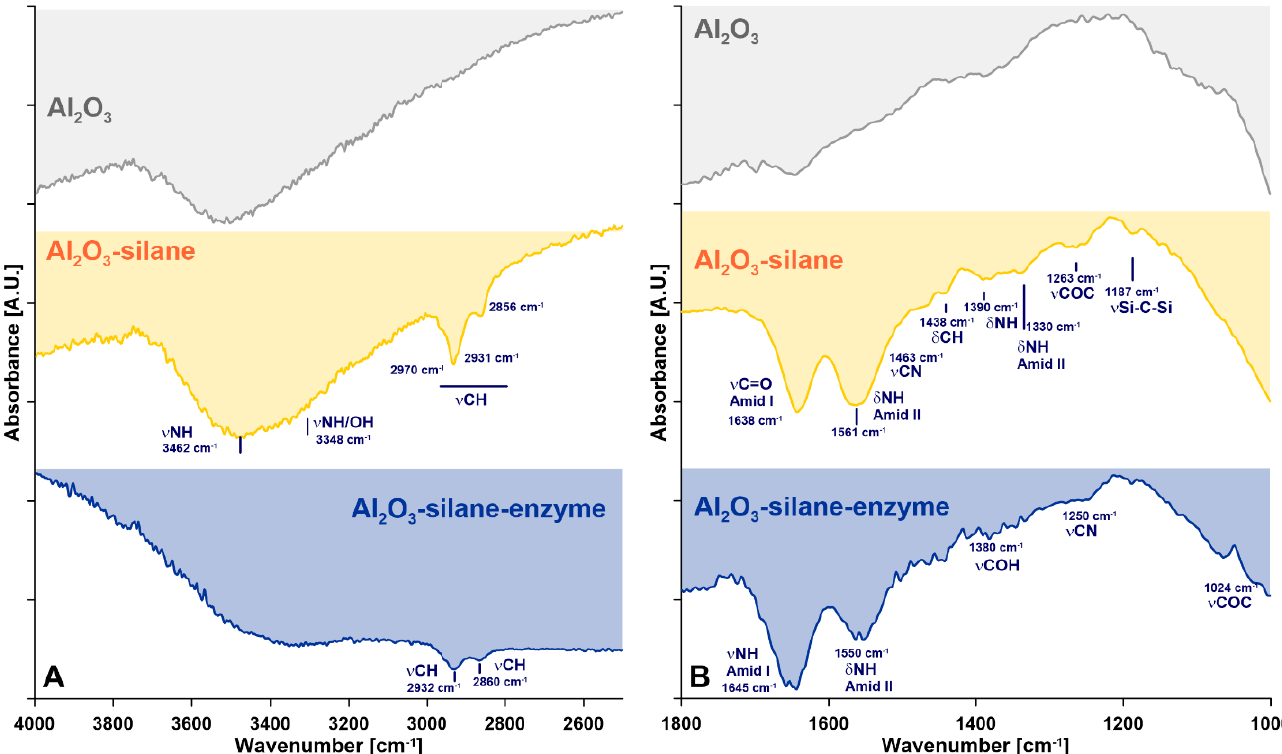
Figure 1. ATR – FTIR spectra of pristine Al 2 O 3 and Al 2 O 3 modified with silanes: ( A ) range of 4000 – 2500 cm −1 , ( B ) range of 1800 – 1000 cm −1 .